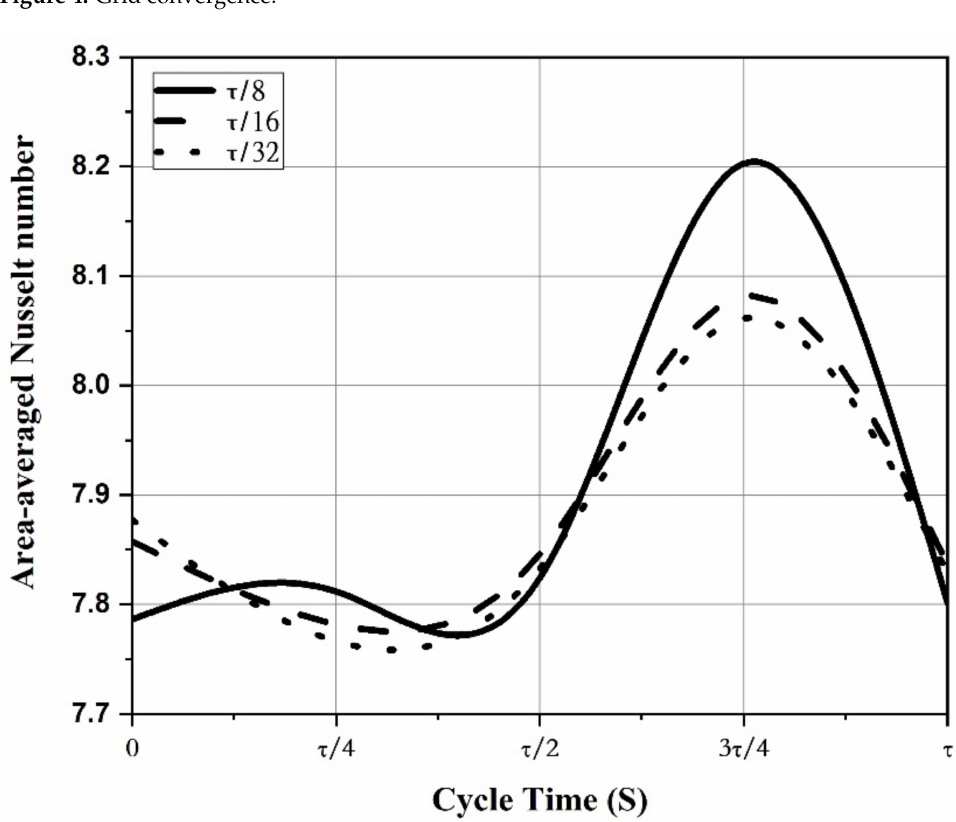
Figure 5. The variations in the area-averaged Nusselt numbers for different time